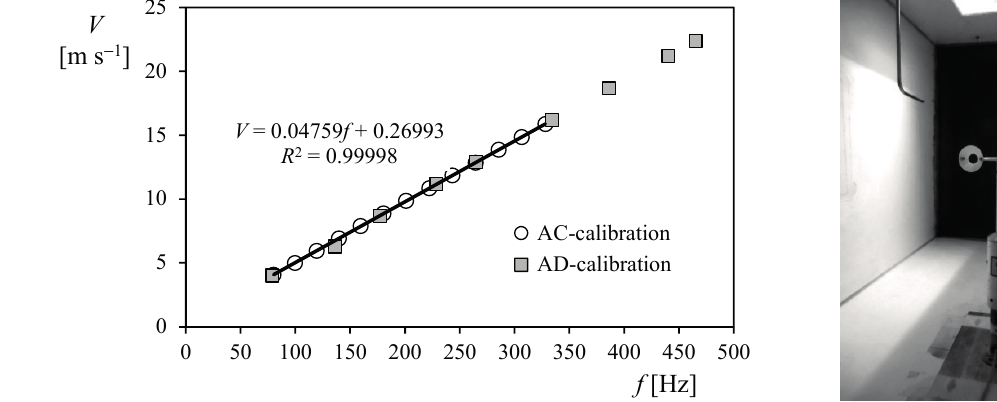
V = 0.04759 f + 0.26993 R 2 =